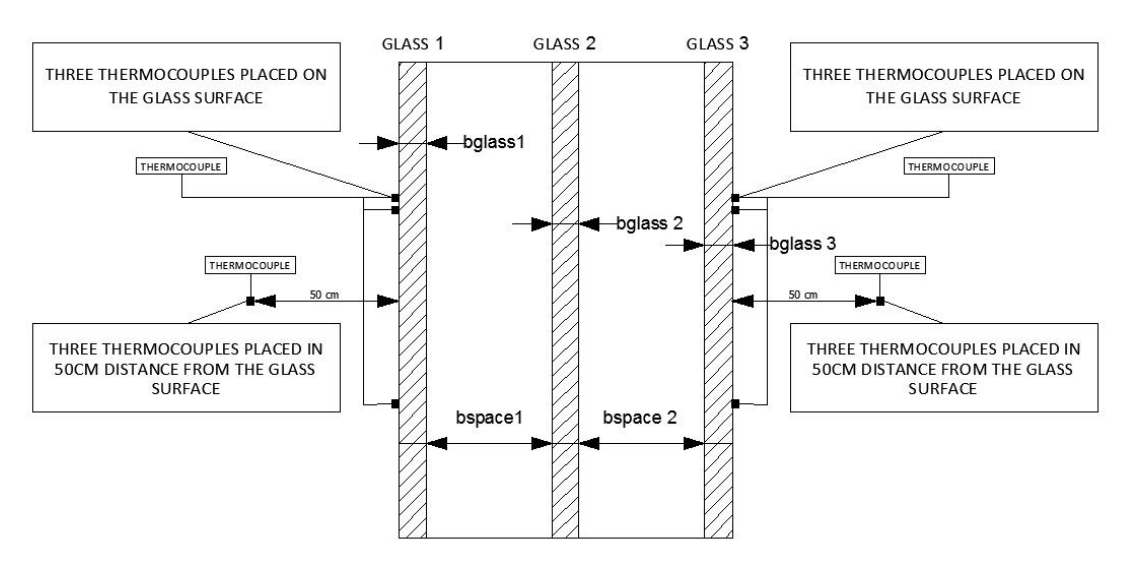
Temperature T 6 is calculated by (4) and it is also measured thus a comparison can be made to justify model